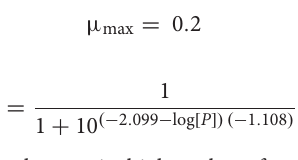
when compared to replicates 1–2 and 20 mM